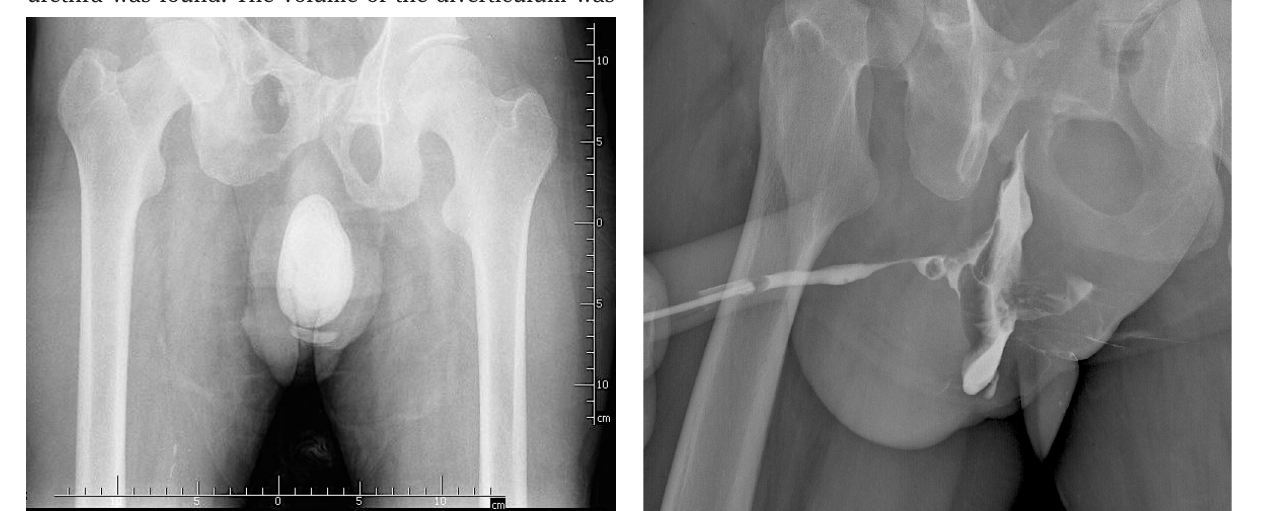
Figure 1: X-ray examination of the pelvis showing a calcareous giant shadow in the view of the urethra suggestive of a stone.